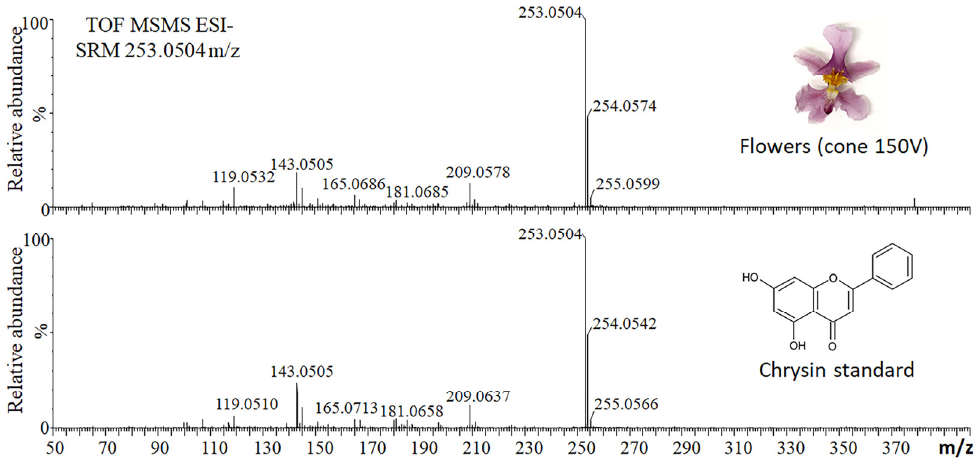
Figure 3. Selected reaction monitoring (SRM) profile of the ion with an m/z value of 253.0504. The flower extract was analyzed in negative ionization mode at a high cone voltage (150 V) to induce the in-source fragmentation of larger metabolites and release the aglycone. The same analysis was applied to the chrysin standard (1 ng/µL). Collision induced dissociation (CID) was carried out using argon gas at 35 eV.